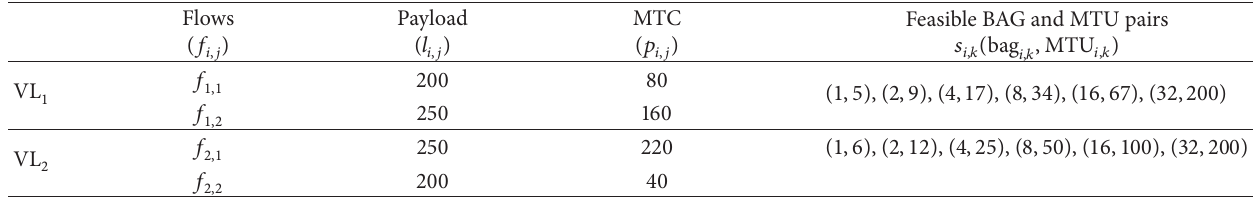
Table 1: An example of virtual links ( 𝐵 = 1